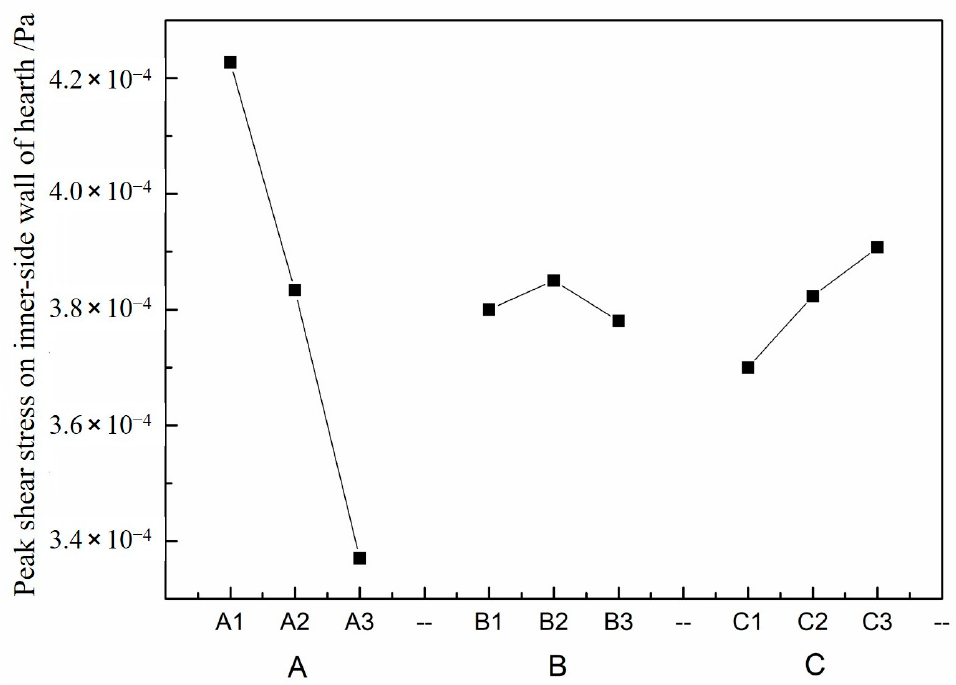
Figure 11. Peak wall shear stress corresponding to each level of each iron tapping factor.